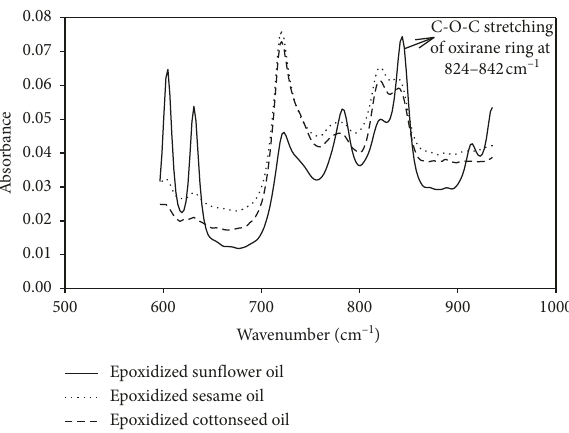
Figure 2: FTIR spectra of epoxydized oils.